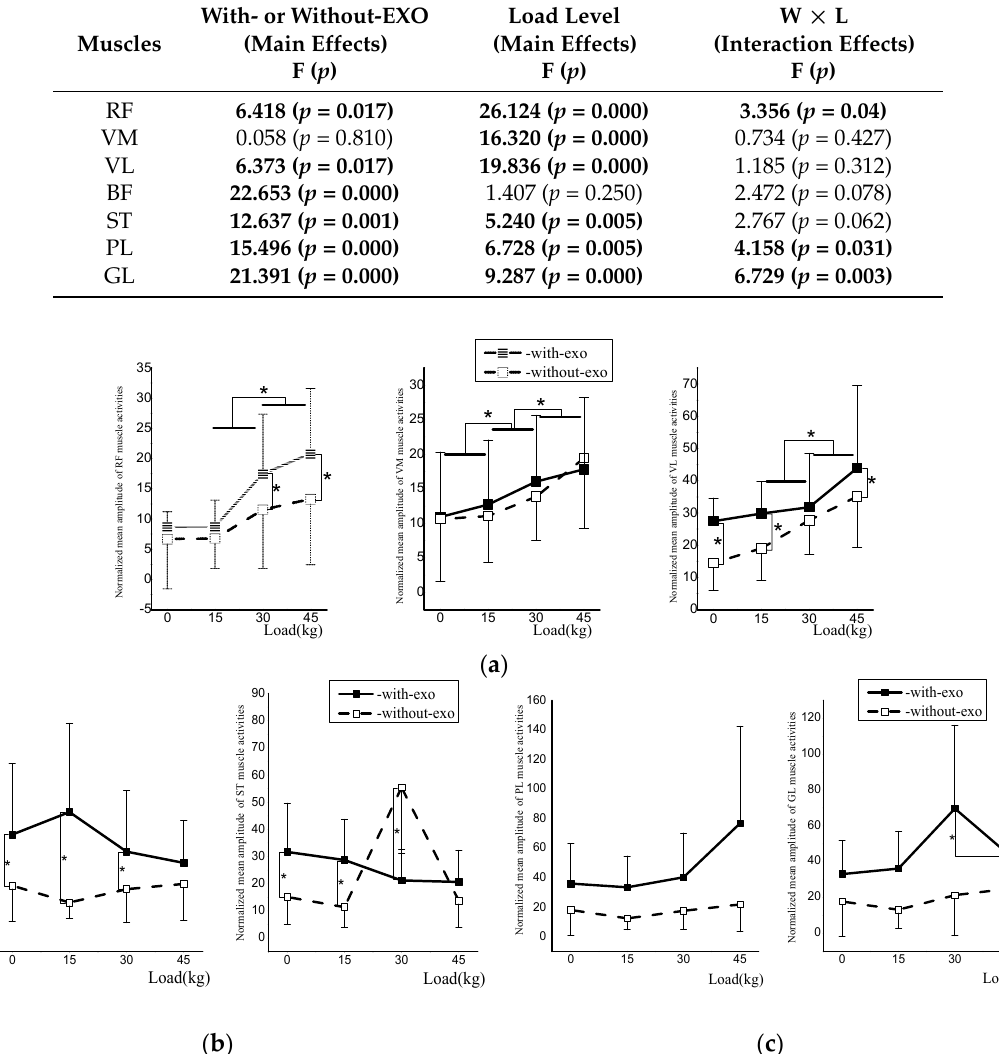
Figure 9. With-Exo or without-Exo and four loading levels effects on initial values of normalized RMS (nRMS) for ( a ) the right knee extensors (RF, VM, VL); ( b ) for the right knee flexors (BF, ST); ( c ) the right plantar flexors (PL, GL). The star ( * ) indicates the significant difference ( p < 0.001) between two related factors.